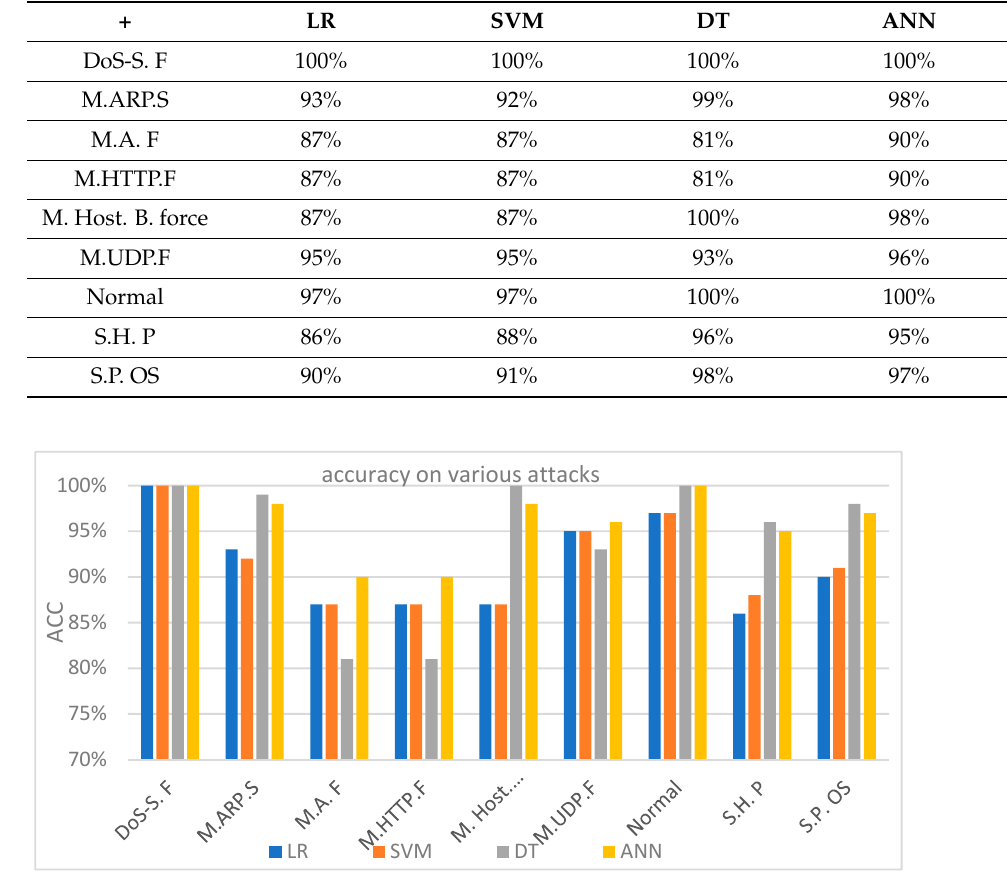
Figure 11. Comparison between ML algorithms.